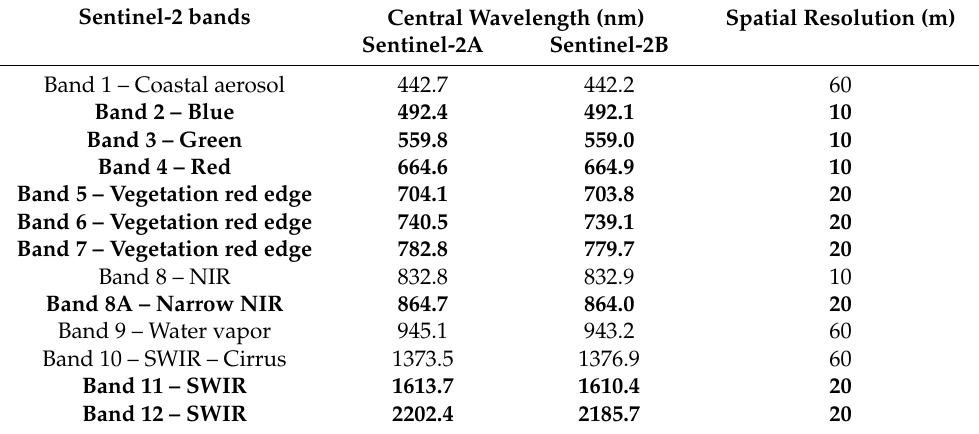
Table 1. Spectral bands of the Sentinel-2 sensors. The bands used in this analysis are in bold letters.